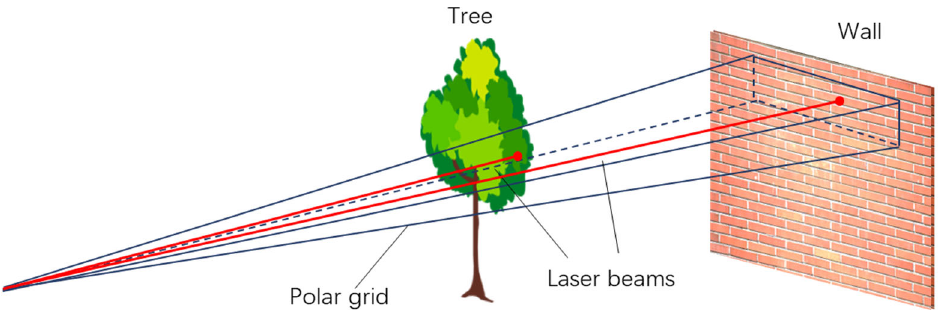
Figure 7. Schematic for describing multiple objects with multiple Gaussian distributions in a polar grid.